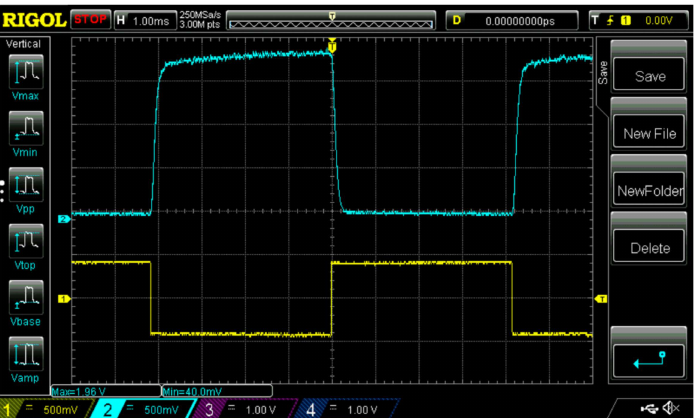
Figure 10. Oscillogram of the electro-optical response in white light ( upper curve ) of the planar- aligned FLC-618, the layer thickness of which in the electro-optical DHFLC cell is 107 µ m. The lower yellow curve is the applied alternating voltage with the amplitude of ± 40